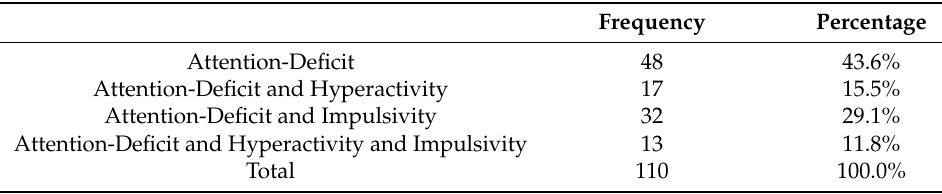
Table 2. Descriptions of the sample in relation to